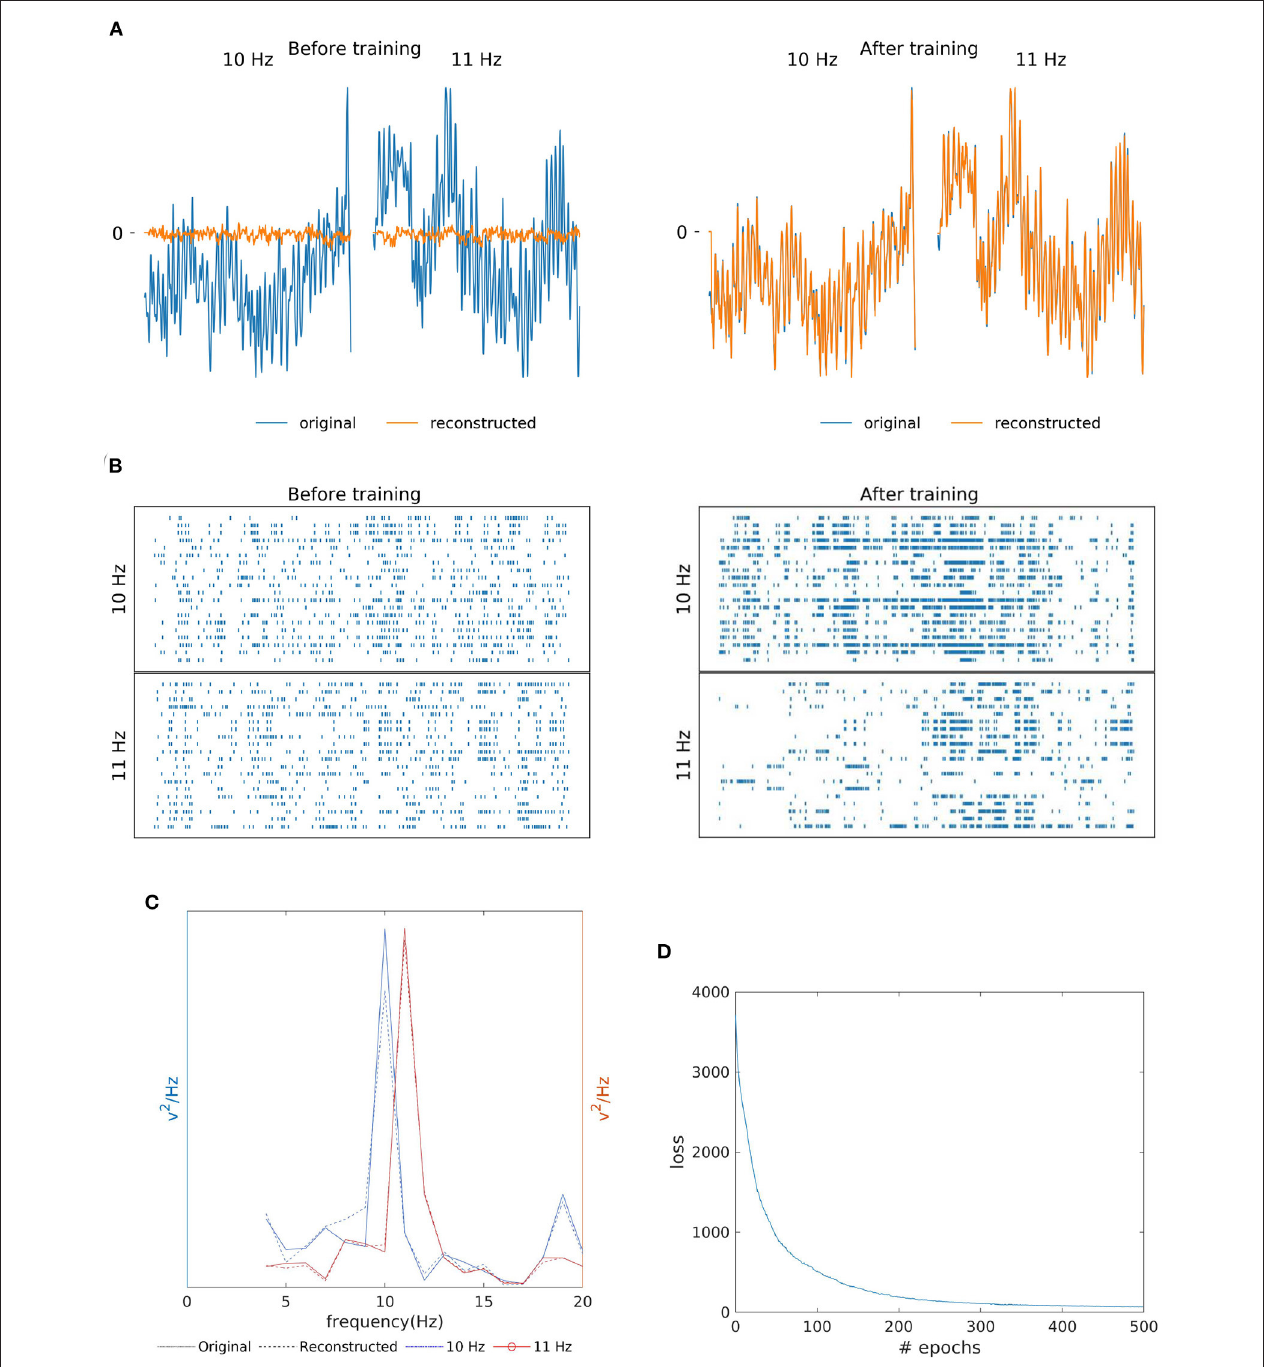
FIGURE 4 | Two class SSVEP signal (10 and 11 Hz) reconstruction outcomes. (A) Illustration of original (blue line) and reconstructed (orange line) SSVEP signal of Oz channel before and after SNN training. (B) Raster plot of 20 randomly selected neuronal spike trains from the hidden layer corresponding to each class before and after training. The yellow box shows that the training process was effective at reorganizing spike trains. (C) Original (bold line) and reconstructed (dashed line) power spectra if signals recorded from the Oz channel are similar, indicating the preservation of the SSVEP biomarker in the reconstructed signal. (D) The loss value (MSE) across epochs during the training